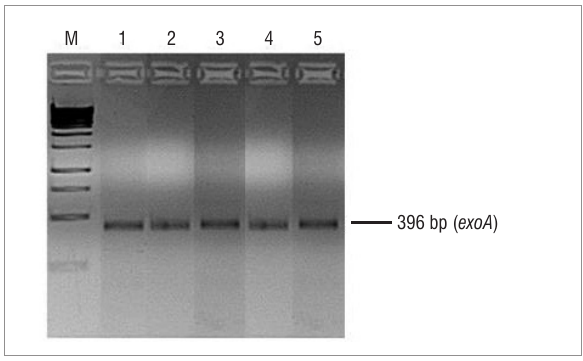
Figure 8: Image of an agarose (1% w/v) gel depicting the exoT gene from Pseudomonas species.